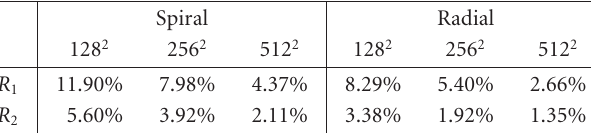
Table 1: L 2 error comparison of reconstruction results with direct reconstruction ( R 1 ) and leakage reduction reconstruction ( R 2 ) on spiral and radial